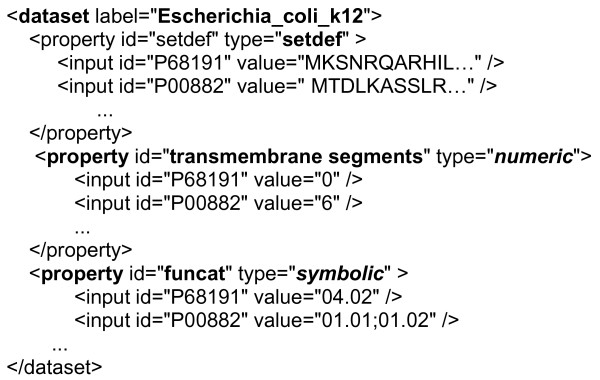
Example PROMPT XML File. The file contains a set definition property that encompasses all E.coli proteins together with their amino acid sequences. Additionally, annotation information stored in the numeric property transmembrane segments and in the symbolic property funcat is provided.